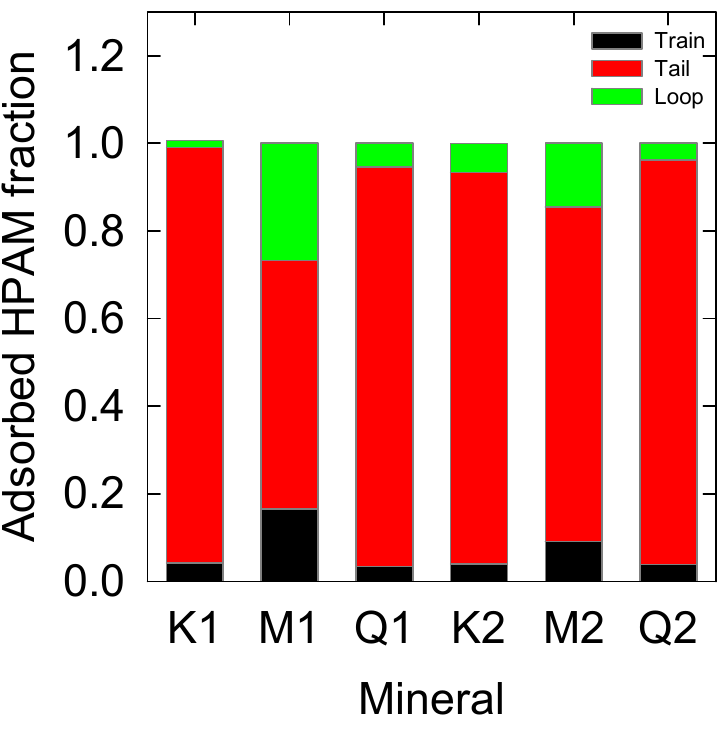
Figure 4. PAA conformation on kaolinite (K), montmorillonite (M) and quartz (Q). K1, M1, and Q1 are at 0.06 M salt concentration. K2, M2, and Q2 are at 0.6 M salt concentration. The discussed results are supported by simulated top and side view images of the conformation of adsorbed PAA on the different surfaces (Figure 5). For kaolinite and quartz, a snapshot simulation was used at 0.6 M and for montmorillonite at 0.06 M because these conditions generate greater polymer adsorption on each mineral. Simulation snapshots were selected that were representative of the simulation, that is, they had values of train, tail, and loop close to those obtained on average. For kaolinite, it is observed that a large part of the chain is exposed to the medium, and a low portion is actually adsorbed on the surface. This effect can be generated by the high density of PAA and kaolinite active sites, making effective adsorption difficult. The d-spacing separates the active sites of montmorillonite, improving its interaction with PAA, increasing loops and tails configurations. Even with the 1.2-nm d-spacing used, the polymer cannot internally adsorb in the montmorillonite, as sodium cations do. Finally, the quartz shows that the adsorption is low, and a portion of the chain is in the vicinity of the surface. This may imply that the polymer has an affinity with the surface but not enough to be adsorbed because it does not have surface sites strong enough to generate effective